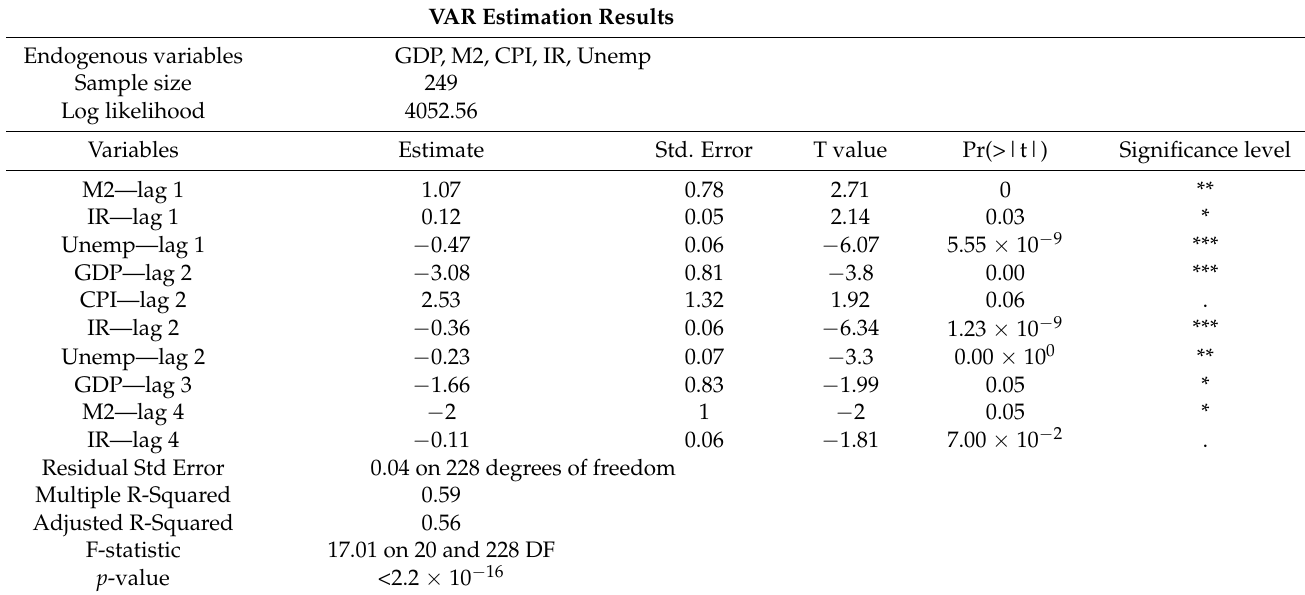
Table 9. VAR estimation for the Unemployment rate